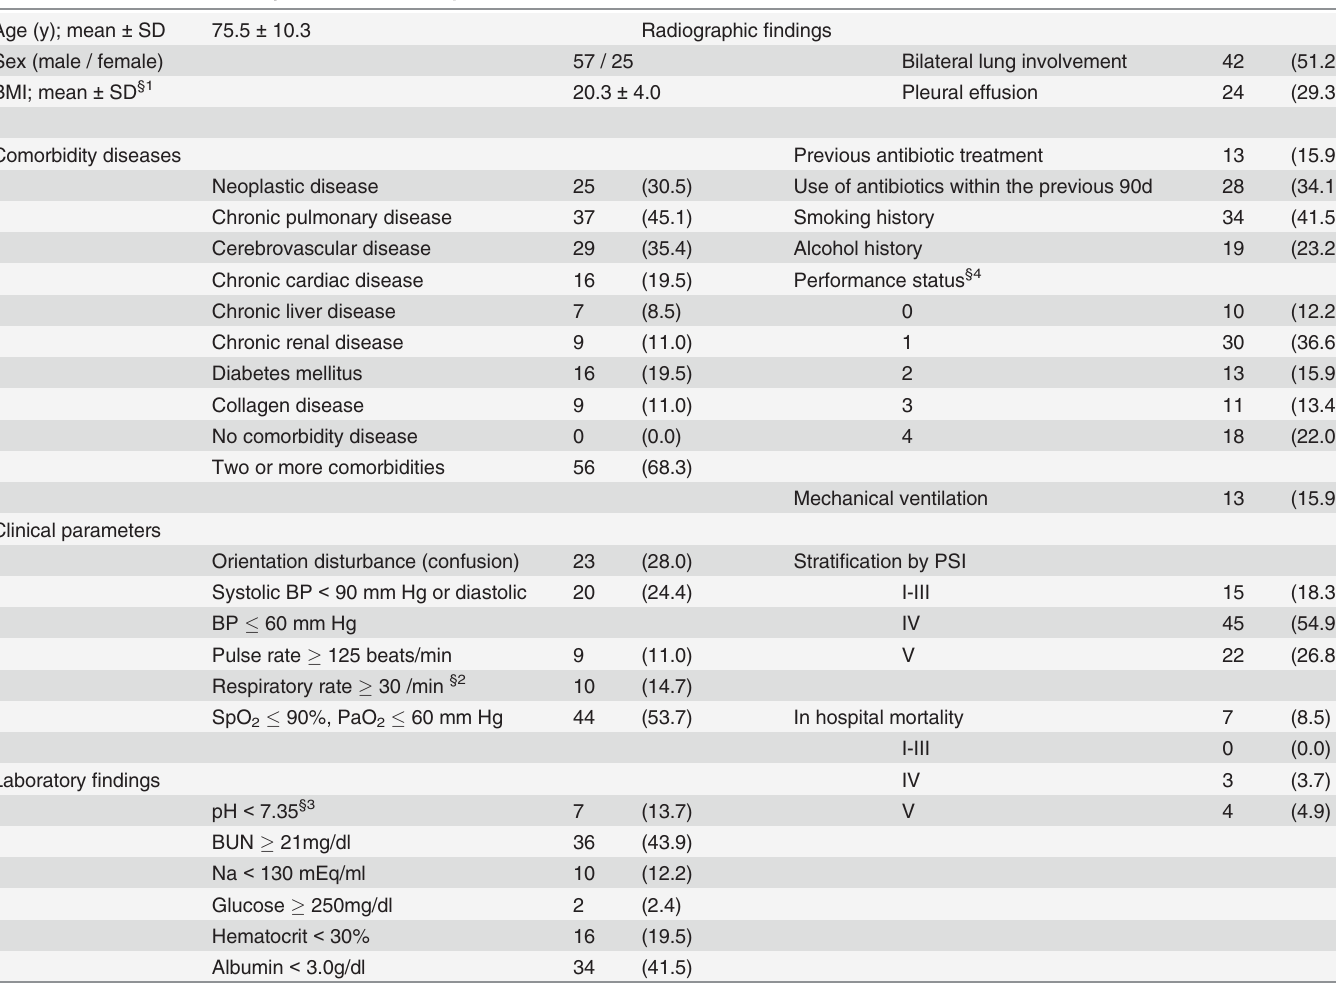
Table 1. Clinical and laboratory features of the 82 patients with